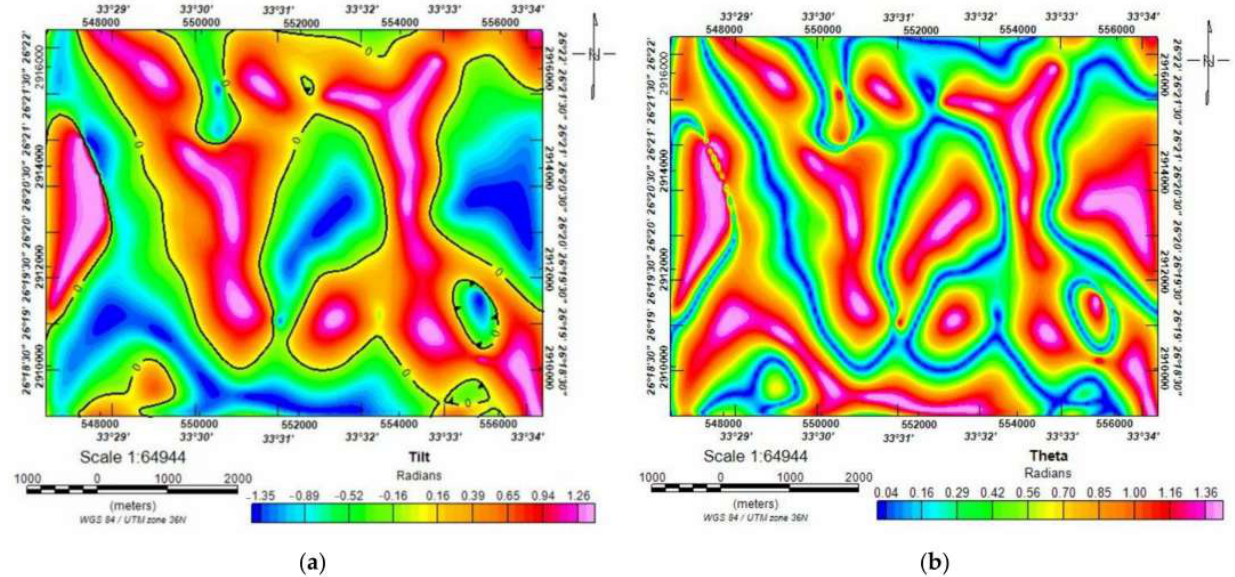
Figure 10. ( a ) A tilt angle (TA) map of the study area. (The boundaries of anomalous sources are considered to be in vertical contact as a result of the zero contours). ( b ) A Theta map. On the other hand, the Theta map of the study region shows the tilt angle map’s opposing amplitudes (Figure 10b). The Theta and TA maps both play roles in synchronizing and balancing between tiny and big